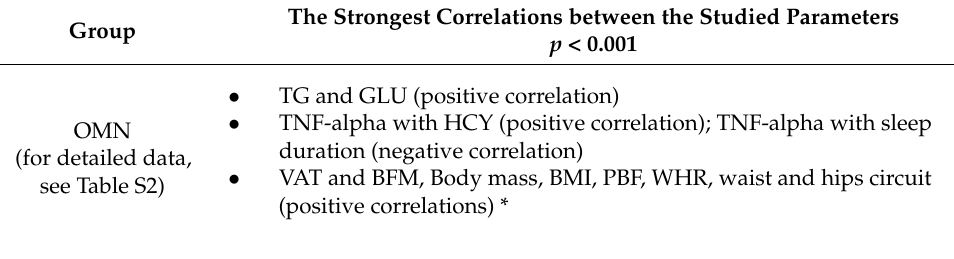
Table 2. The strongest correlations between the parameters in the study groups. The Strongest Correlations between the Studied Parameters Group p <